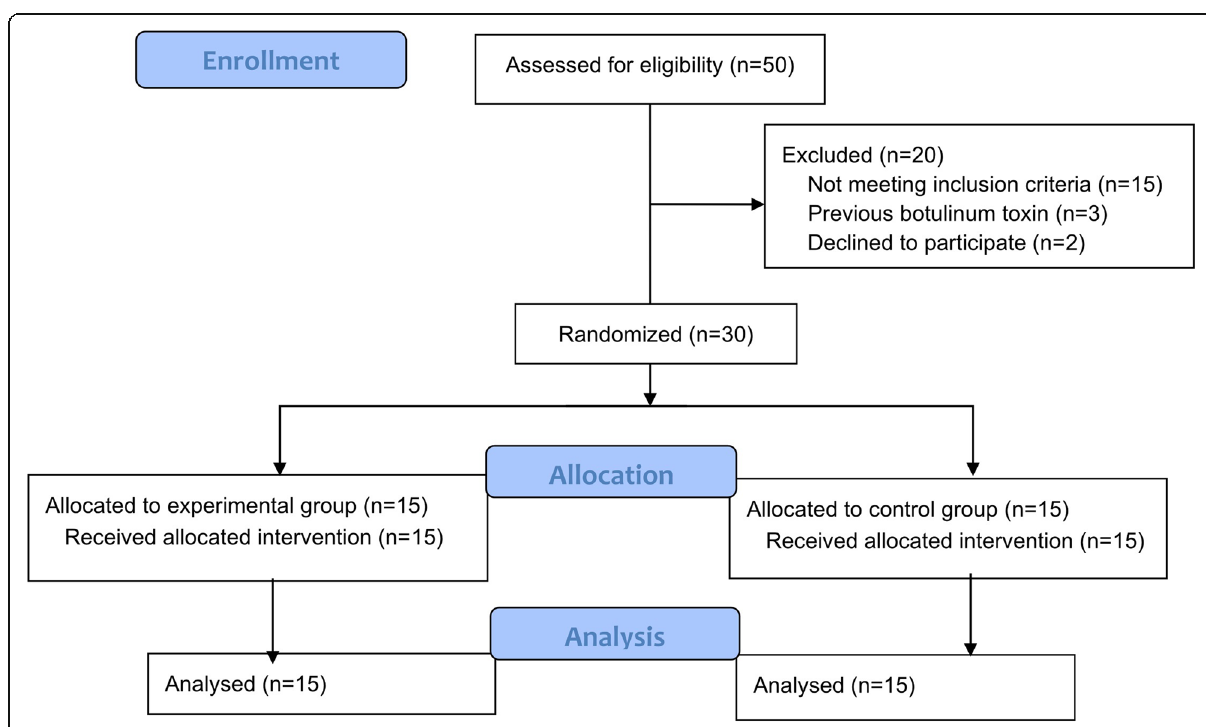
For both experimental and control groups: the follow- ing tools were used to administer the selected exercises program: shoelace, card with holes, hair brushes, rattles, scissors, bottles with screw-on caps, large button strip, brushes, toys, penny, sponge, and different sized